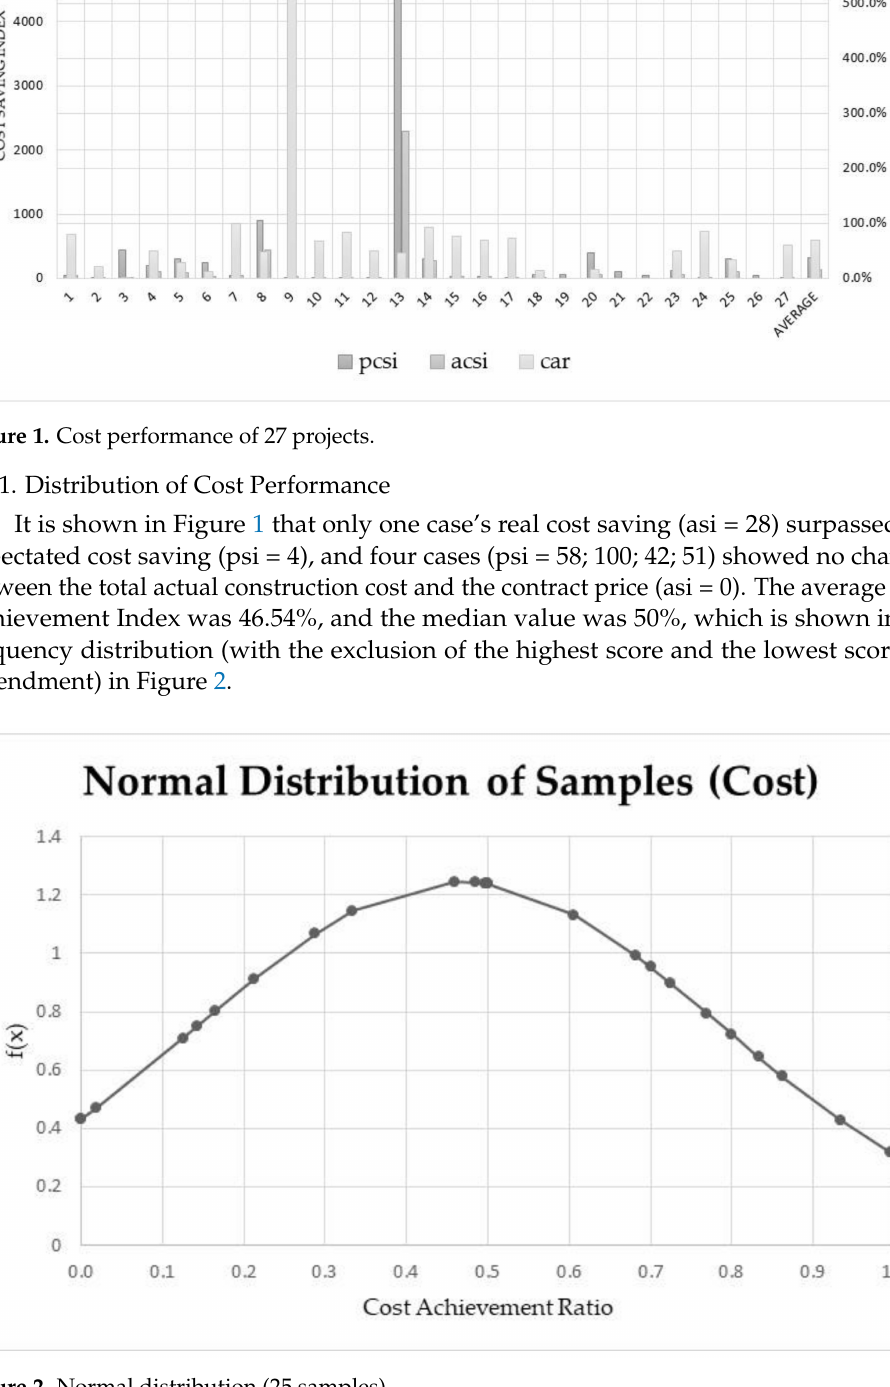
Figure 2. Normal distribution (25